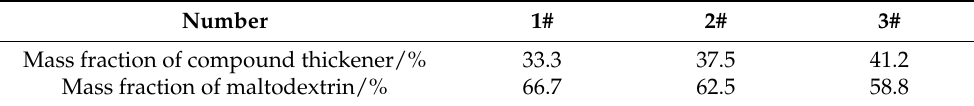
Table 2. Content of each component of the 3 formulations of thickening component based on KGM for special medical